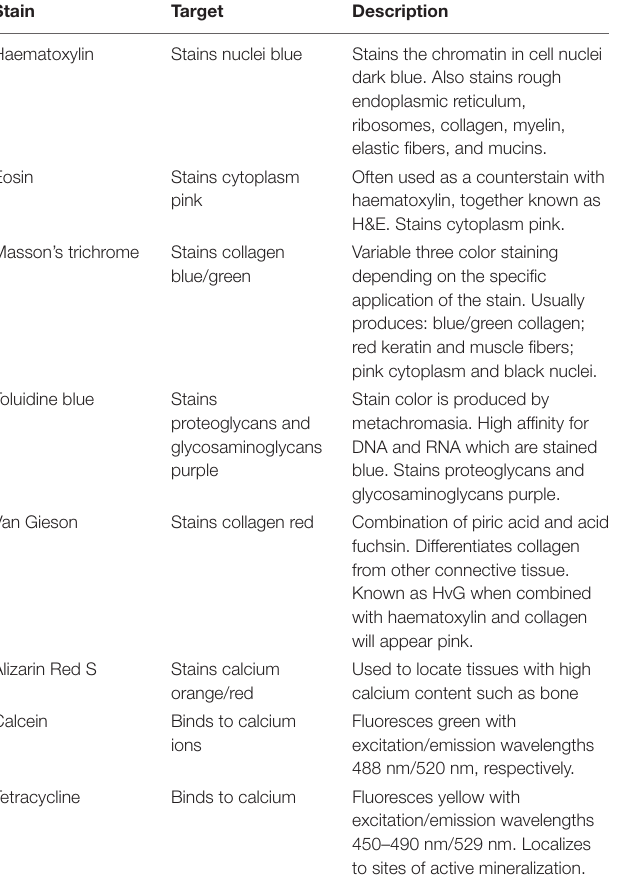
TABLE 1 | Common stains used in assessing osteogenesis and angiogenesis. Stain